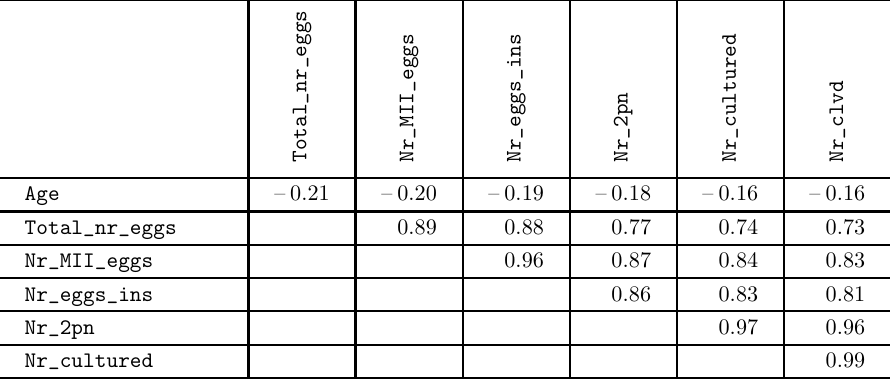
Table 5. Correlations between independent